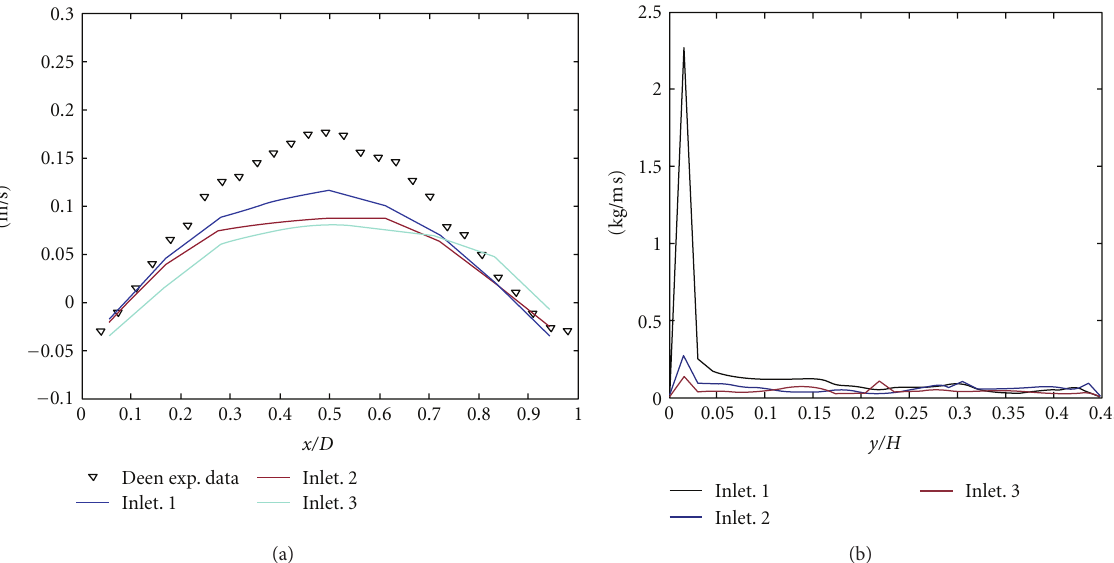
Figure 4: Comparison of (a) averaged axial liquid velocity profile at 𝑦/𝐻 = 0.56 , (b) instantaneous viscosity profile along the height of the column (120s) for three inlet conditions (from Bove et al.